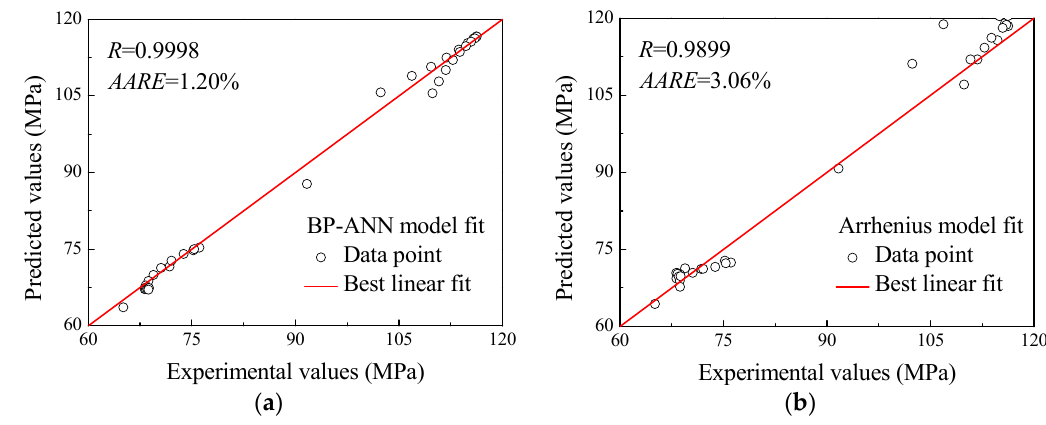
Figure 9. The correlation relationships between the predicted and experimental true stress for the ( a ) BP ‐ ANN model and ( b ) Arrhenius ‐ type model.